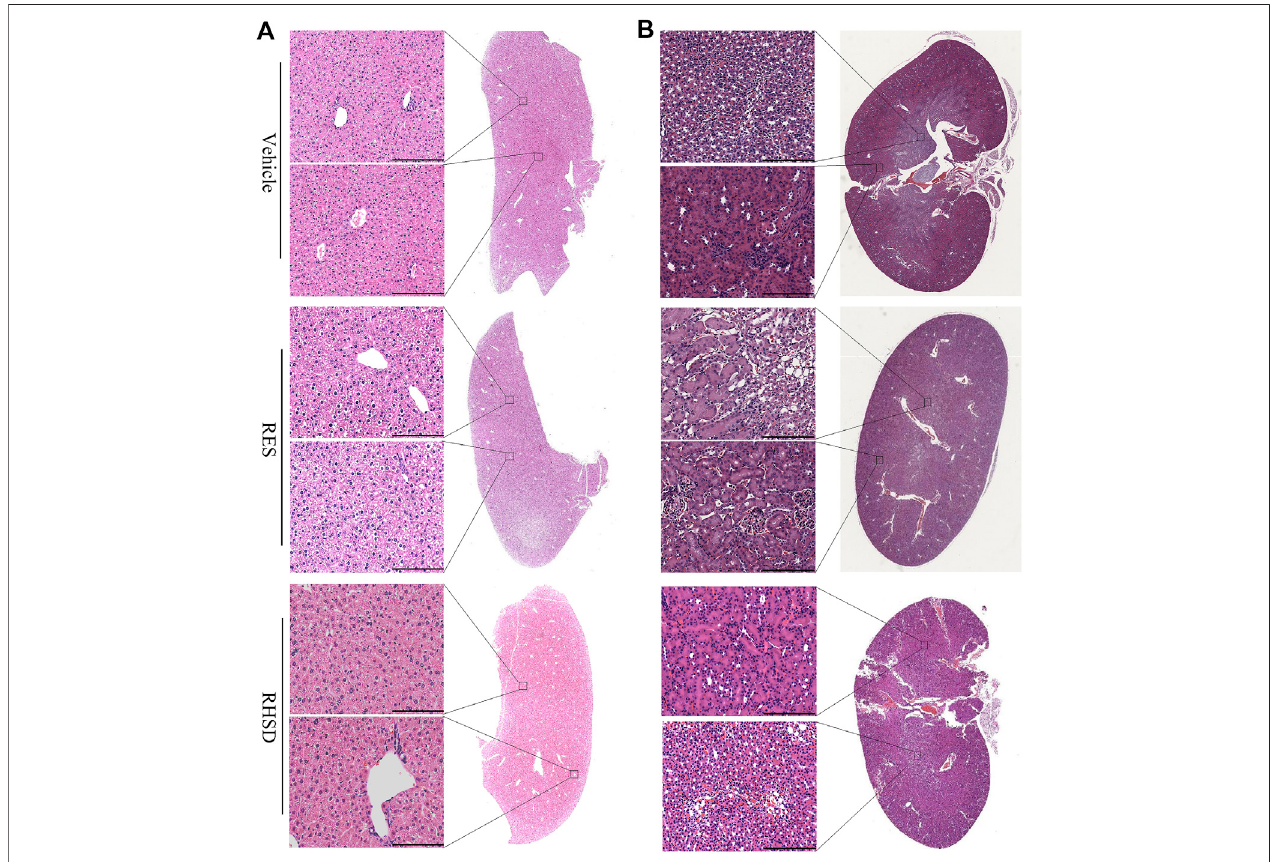
FIGURE 8 | RES and RHSD are effective cervical cancer inhibitors with low toxicity. H&E staining of main organs of tumor-bearing nude mice after treatment. Full section scan and local magni fi cation of Live (A) and kidney (B) , Scale bar: 75 μ m.